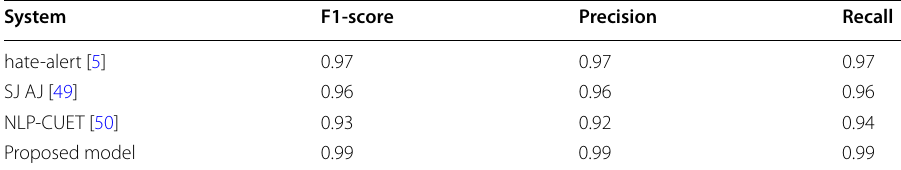
Table 7 OLD accuracy of the proposed model compared with published results in EACL 2021 System F1‑score Precision